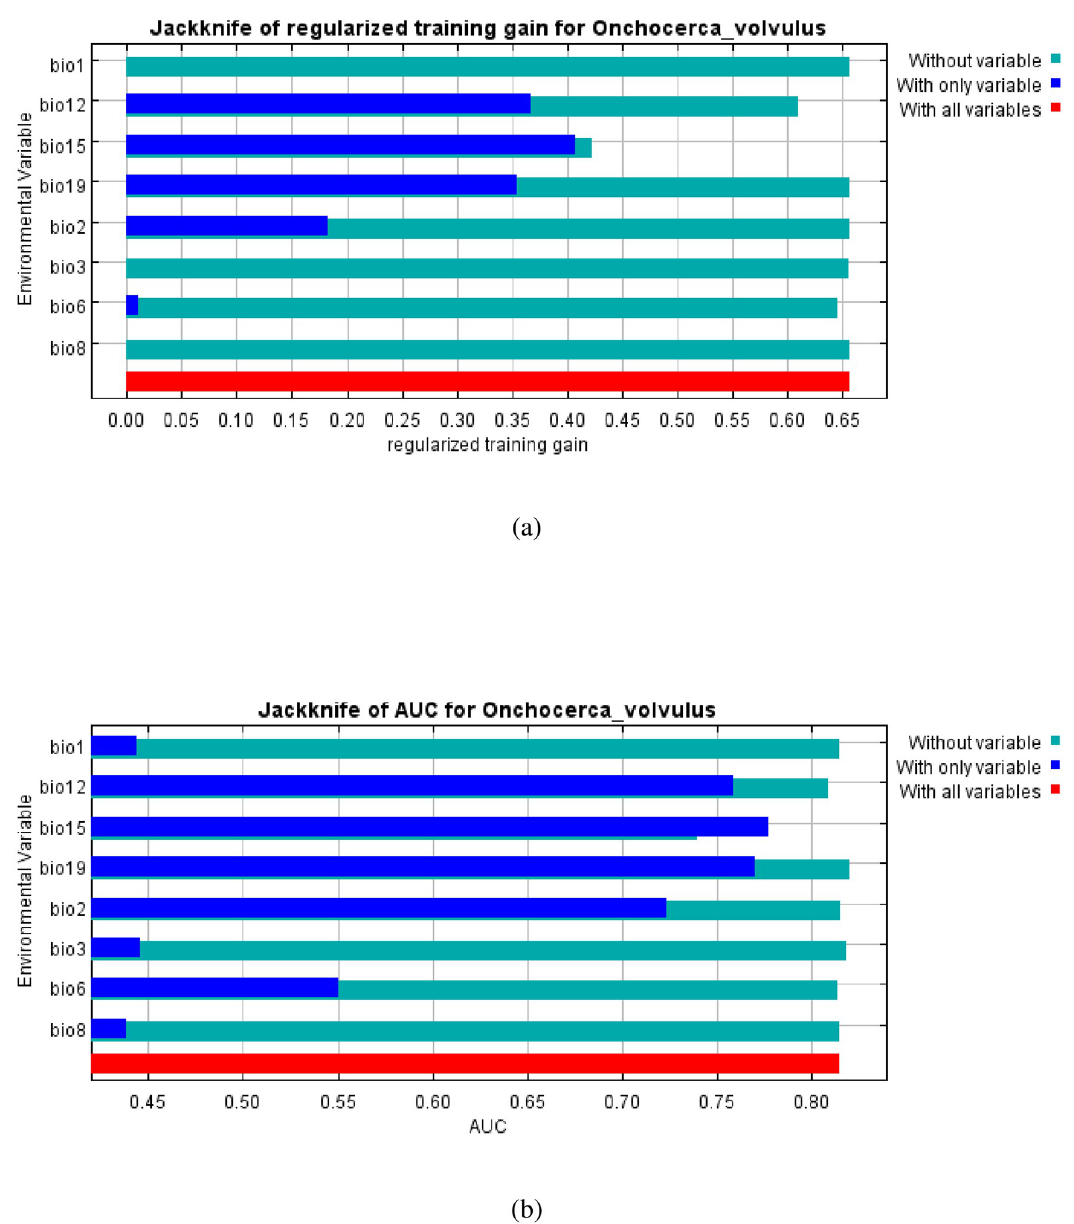
Fig 7. Jacknife analysis (a) training gain (b) AUC. The dark blue, light blue and red bars represent results of the model with each individual variable, all the remaining variables and all variables respectively.